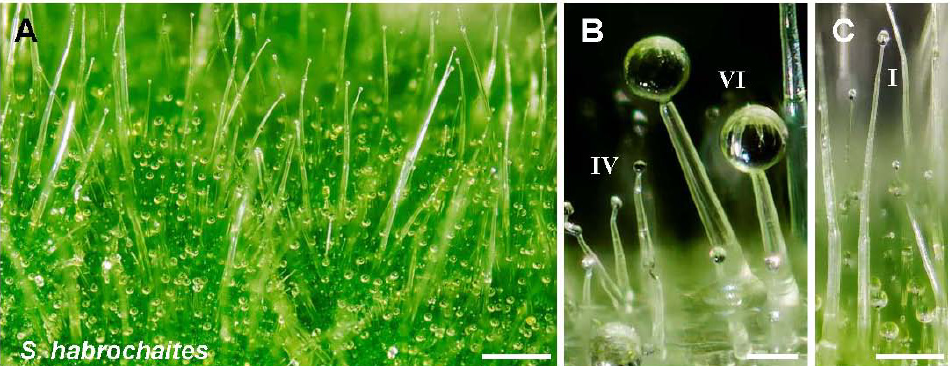
Figure 1. Glandular trichomes in section Lycopersicon . Wild accessions have high densities of glandular trichomes that confer resistance to several pests. Panel ( A ) shows the leaflet surface of Solanum habrochaites acc. LA 1777 with high densities of glandular trichome types IV and VI ( B ), and type I ( C ). Surface of Solanum pennellii acc. LA 716 is also covered by type IV trichomes ( D , E ) producing and secreting acyl sugars. This accession also has type VI trichomes, but in low density ( F ). Panel ( G ) shows the surface of Solanum lycopersicum cv. Moneymaker. Cultivated tomato has low density of type VI trichomes ( H ) and type I trichomes. Sometimes, type IV-like trichomes ( I ) are observed on stems, veins, and on the leaflet edges. White bars represent 500 µm in panel A, C, D, and G. In panels B, E, F, H, and I, bars represent 50